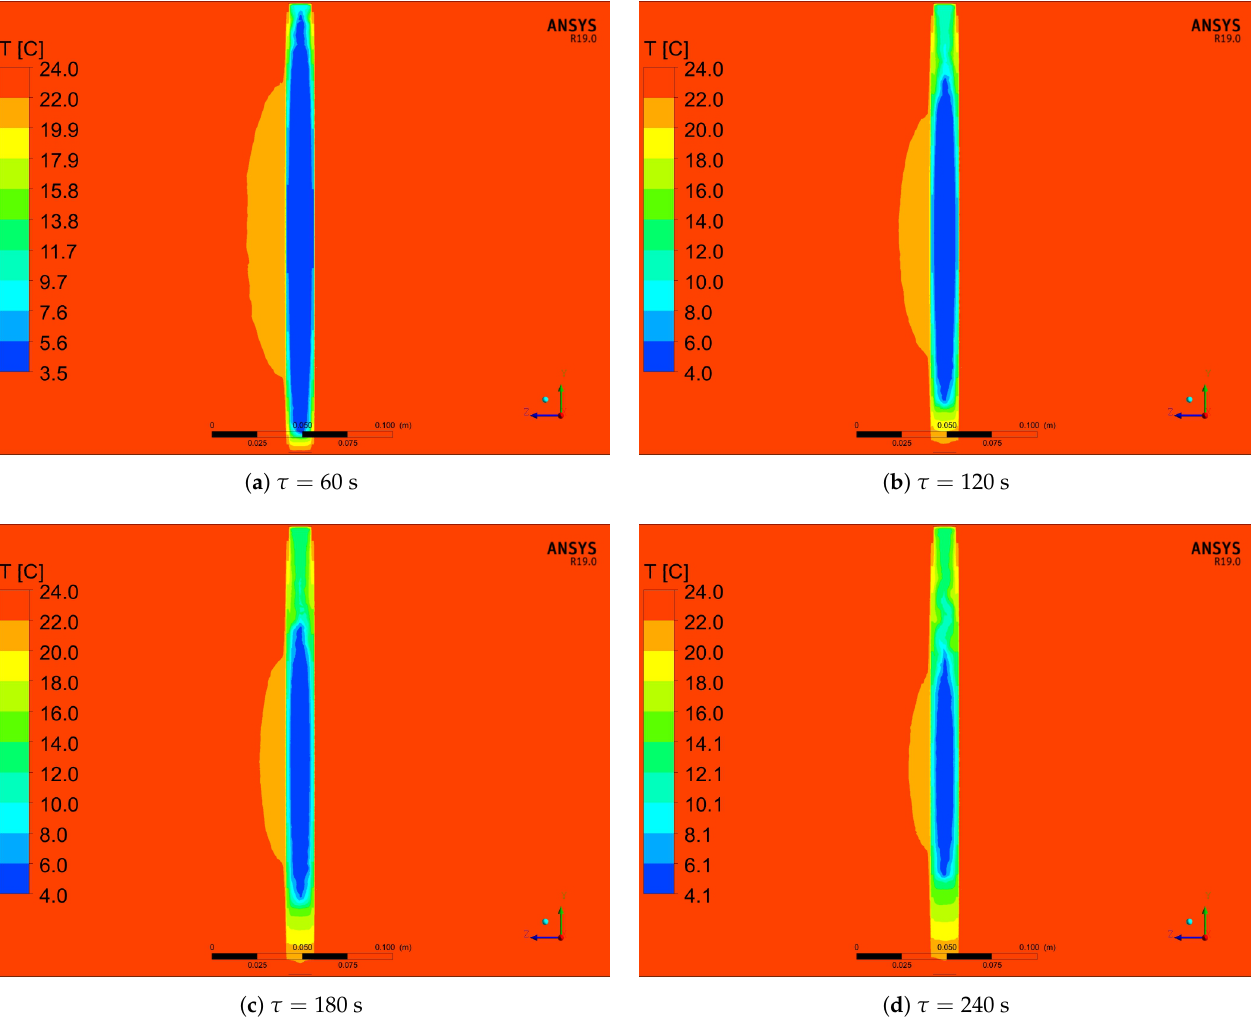
Figure 17. Numerical results of temperature distribution in the middle vertical plane for the inlet velocity of 0.92 m/s and cylinder diameter of 15 mm and different times of the